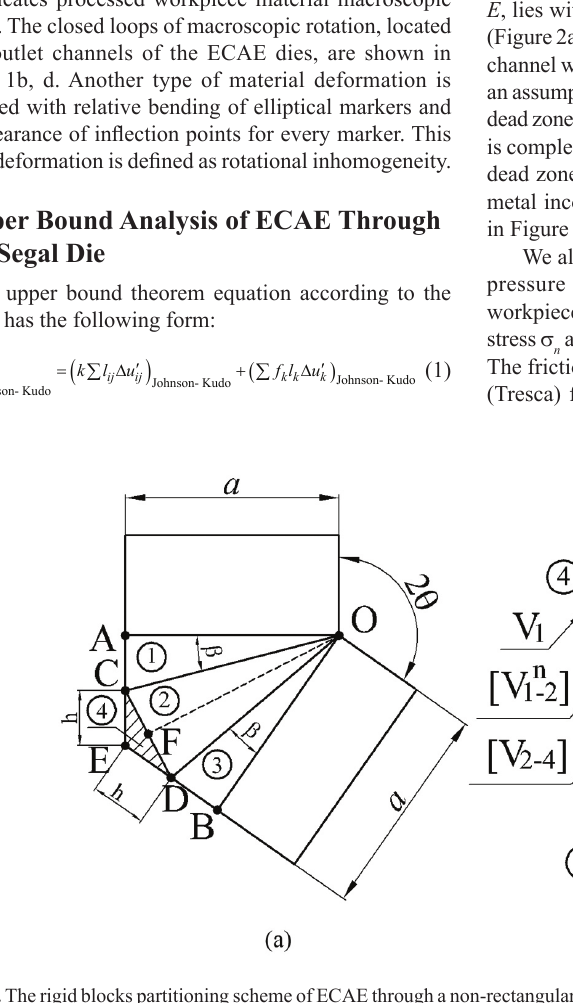
Figure 2. The rigid blocks partitioning scheme of ECAE through a non-rectangular Segal 2 θ -die ( a ) and corresponding velocity hodograph ( b